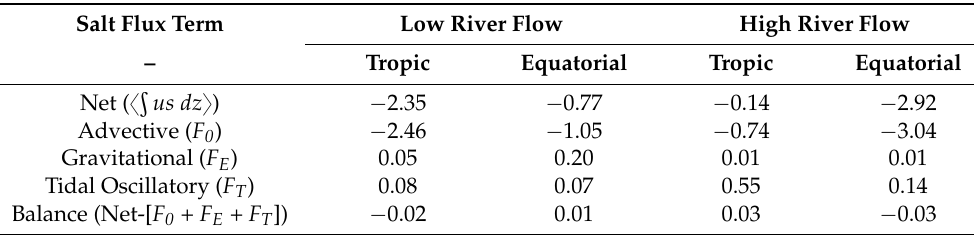
Table 1. Salt fluxes (kg ¨ m ´ 1 ¨ s ´ 1 ) at Cocodrie during the four tidal cycles examined. Salt Flux